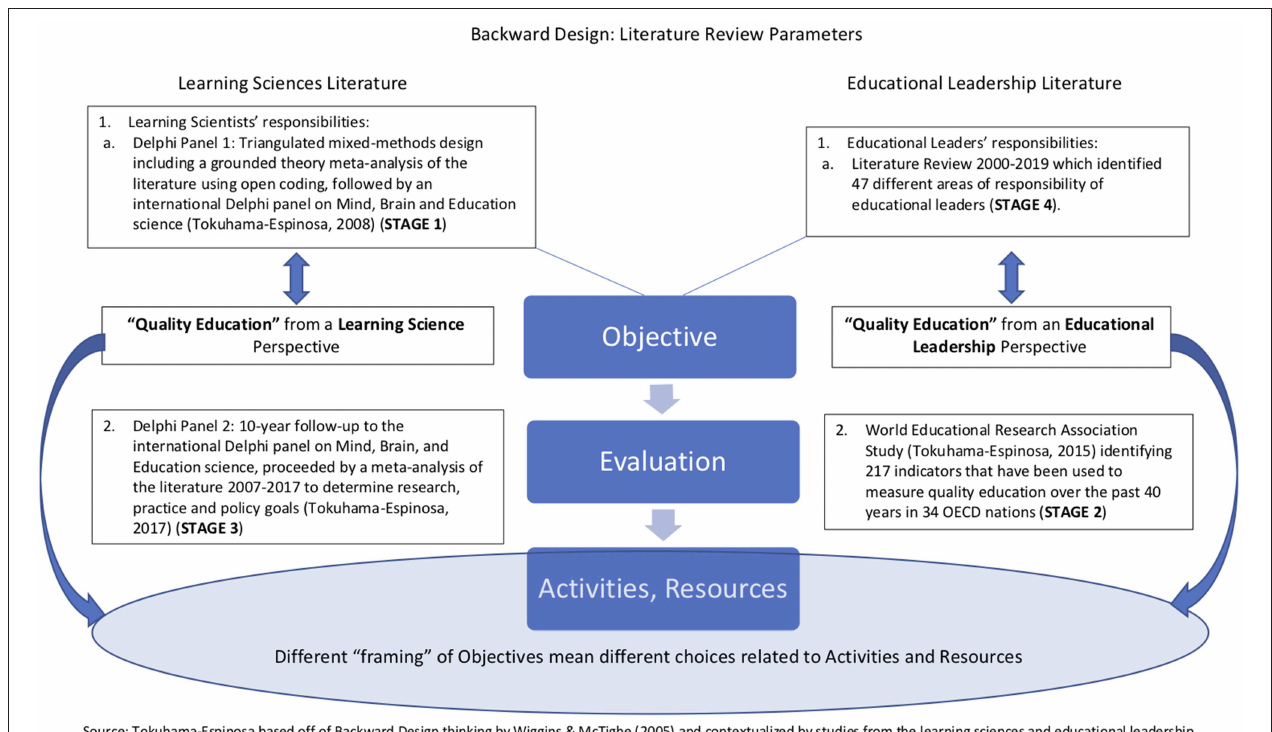
FIGURE 3 | Backward design literature review